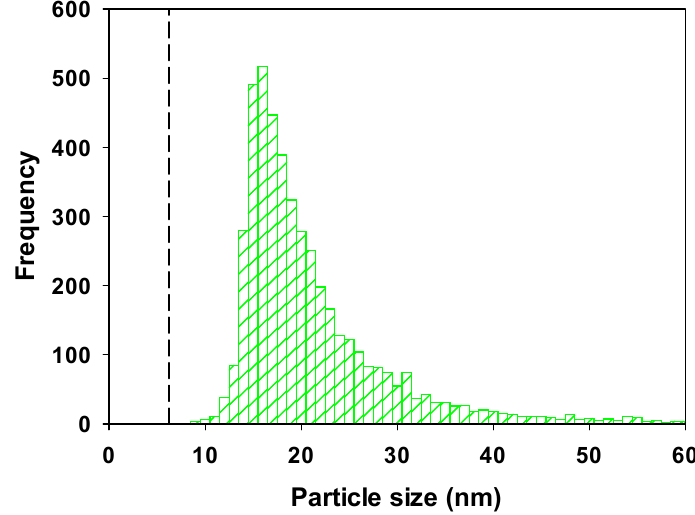
Figure 4. Particle size distributions of Ce containing NPs in a sample taken from the St. Lawrence River. The mean particle size ± polydispersity corresponded to 21.0 ± 9.2 nm. The dashed line corresponds to the SDL. Measurements were obtained using the wet-SF-ICP-MS with a 50 µ s dwell time. NP sizes were calculated by assuming that the particles were spherical CeO 2 particles with a density of 7.13 kg dm − 3 [23].